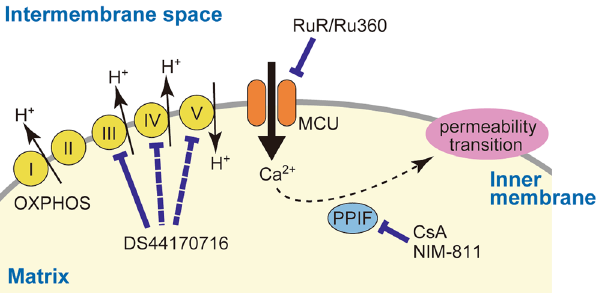
Figure 8. Action mechanism of DS44170716. Mitochondrial respiratory chain complexes generate proton gradient, which is a driving force for Ca 2 + uptake. Ca 2 + overload into the matrix induces mitochondrial permeability transition (MPT). DS44170716 strongly inhibits complex III and weakly inhibits complex IV and V to decrease the potential. The decrease inhibits mitochondrial Ca 2 + uptake and MPT. RuR or Ru360 blocks Ca 2 + uptake by acting on MCU. CsA or NIM-811 inhibits PPIF, a central player promoting